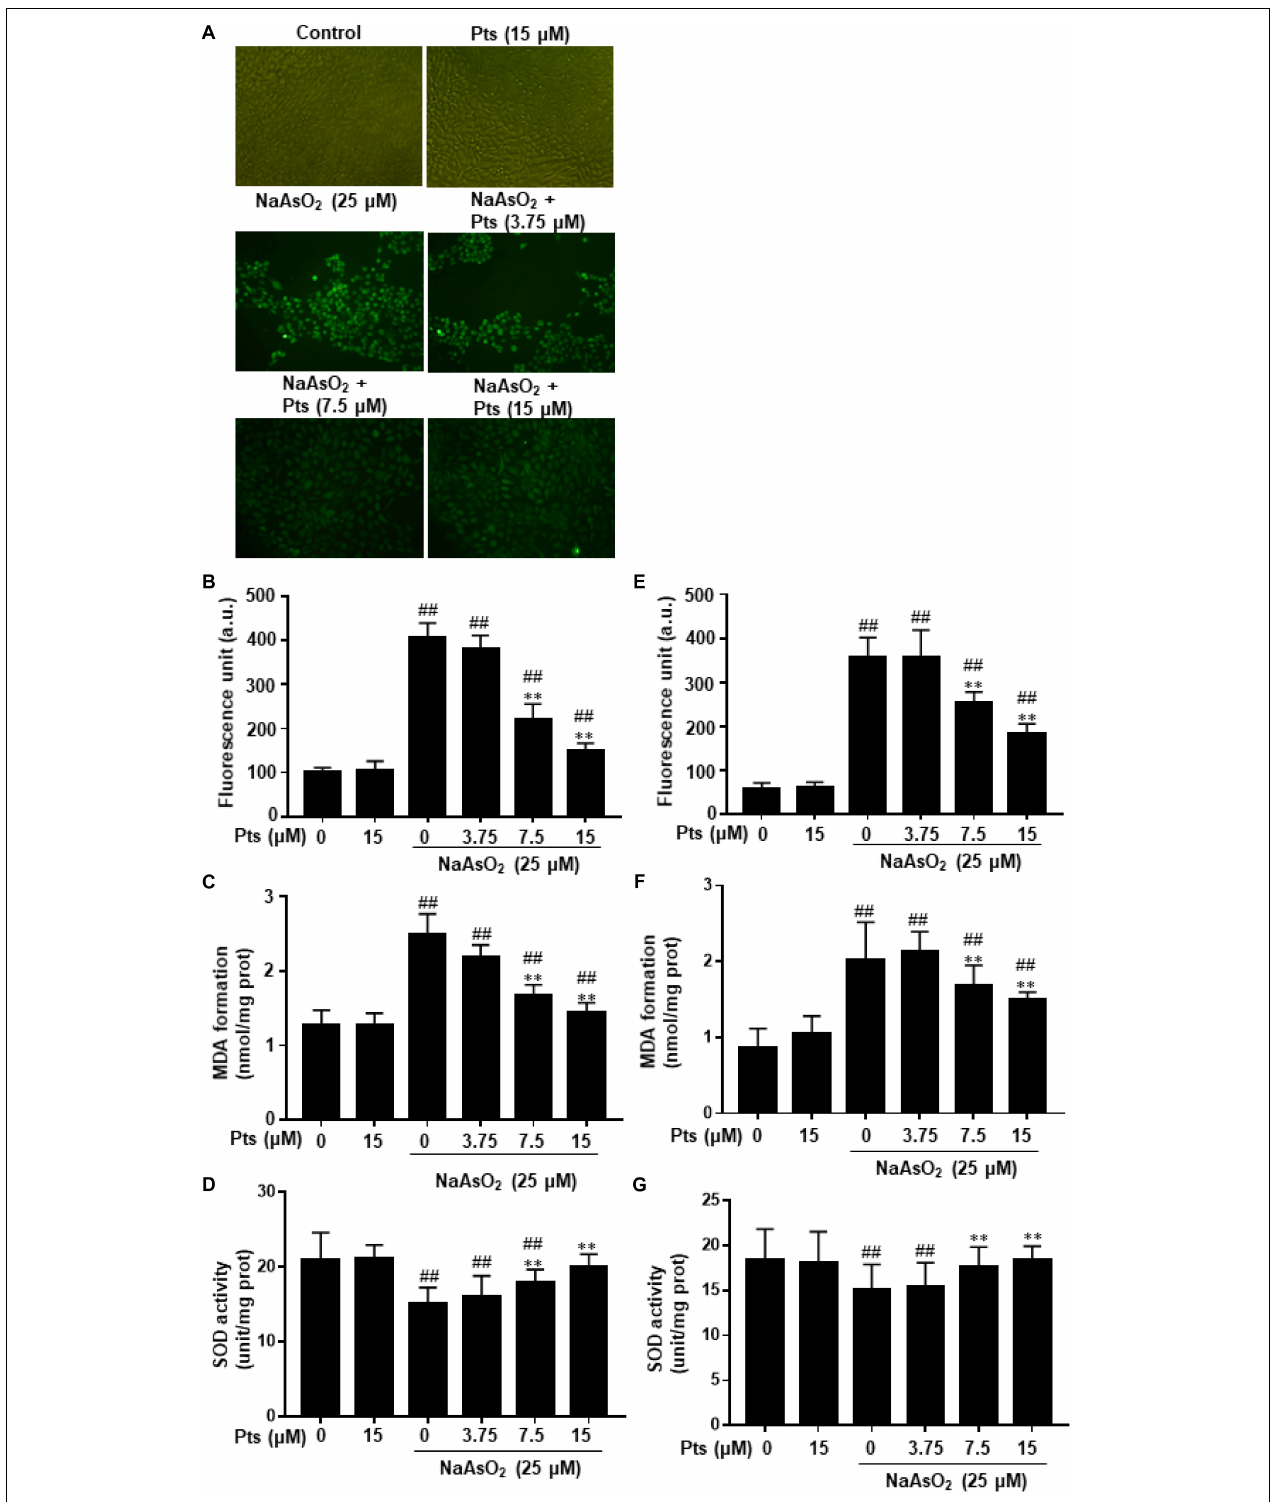
FIGURE 2 | Protective effect of Pts pretreatment against NaAsO 2 -induced oxidative stress in HaCaT cells. The HaCaT and JB6 cells were exposed to 25 µ M of NaAsO 2 for 24 h with or without Pts (3.75, 7.5, and 15 µ M) pretreatment. (A,B,E) ROS generation was measured by the DCFH-DA method using a multi-detection reader and fluorescence microscope at 100 × magnification. Intracellular MDA levels (C,F) and SOD (D,G) activities were determined by commercial kits. The results are expressed as the means ± S.E.M. of three independent experiments. ## P ≤ 0.01 versus the control group, ∗∗ P ≤ 0.01 versus the NaAsO 2 group.